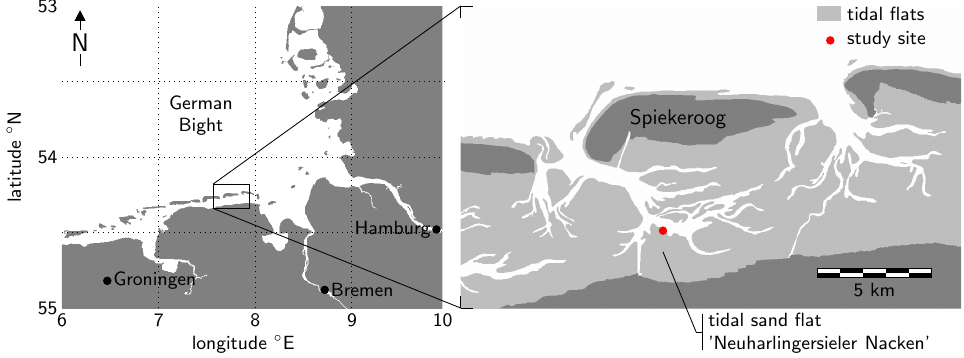
Fig. 1. The study site (red dot) in the back barrier area of Spiekeroog Island, Wadden Sea, Germany is located at the northern rim of an intertidal sand flat (Neuharlingersieler Nacken). The locations of the cores NN1 and NN2 are located along a transect perpendicular to the charted low water line in distances of 10 and 50m to the low water line, respectively.